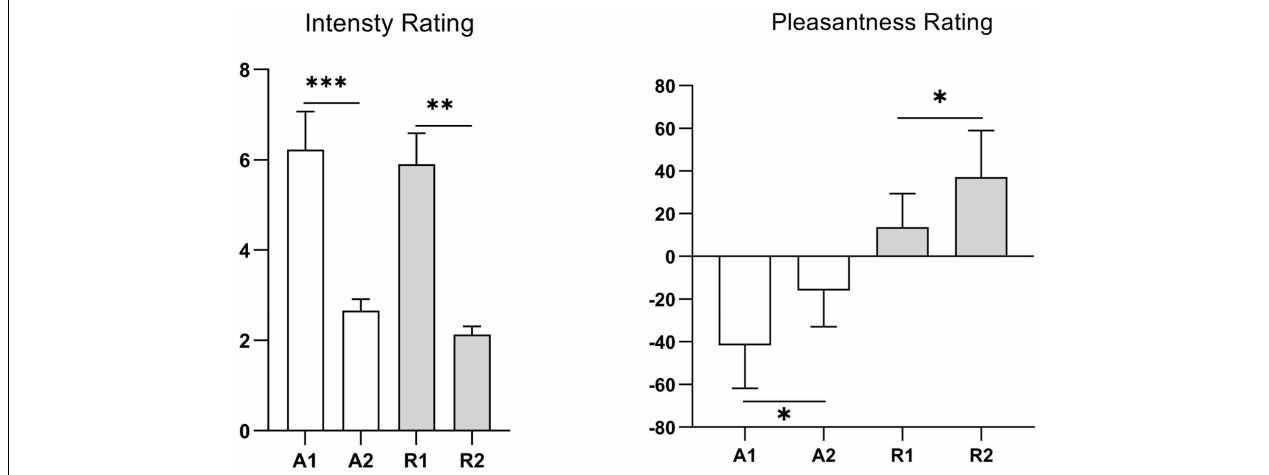
FIGURE 2 | Odor concentration intensity and pleasantness ratings of participants in the formal study. A1, represents strong ammonia concentration; A2, weak ammonia concentration; R1, strong rosemary essential oil concentration; R2, weak rosemary essential oil concentration. Values represent the mean, and error bars indicate the standard error (SE). ∗ p < 0.05; ∗∗ p < 0.01; ∗∗∗ p < 0.001.